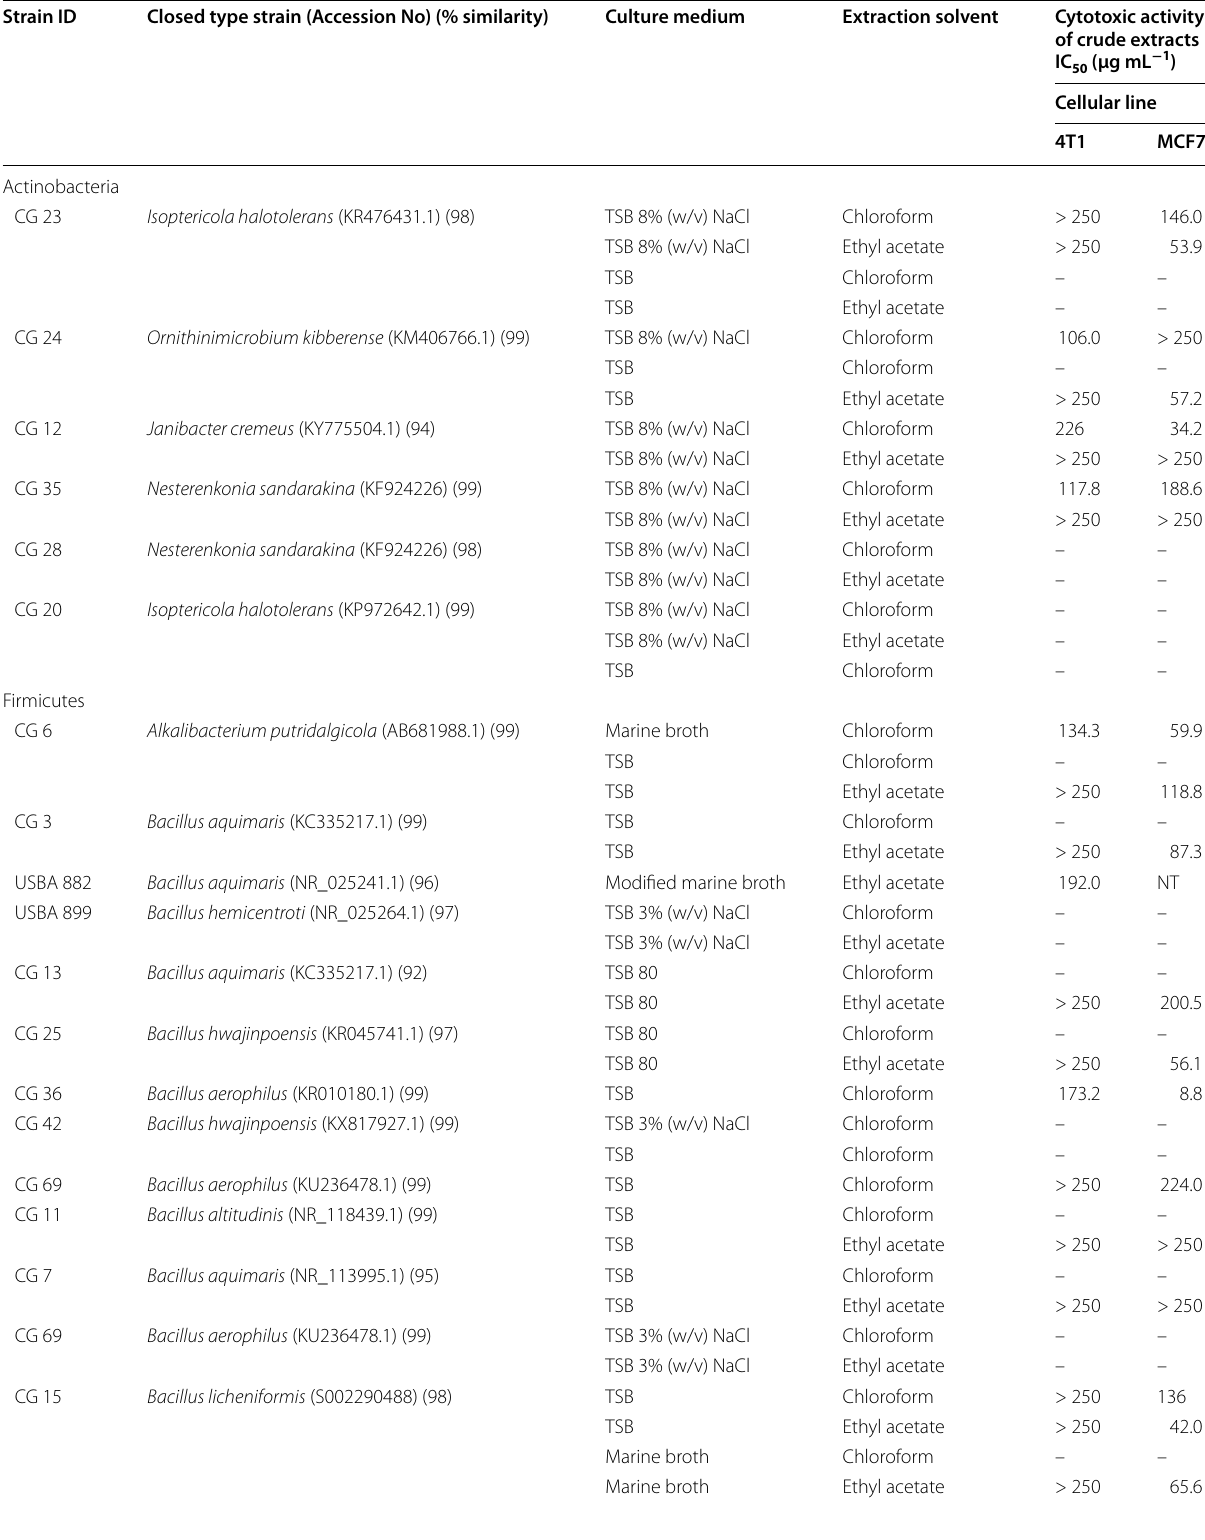
Table 1 Cytotoxic activities of evaluated strains Strain